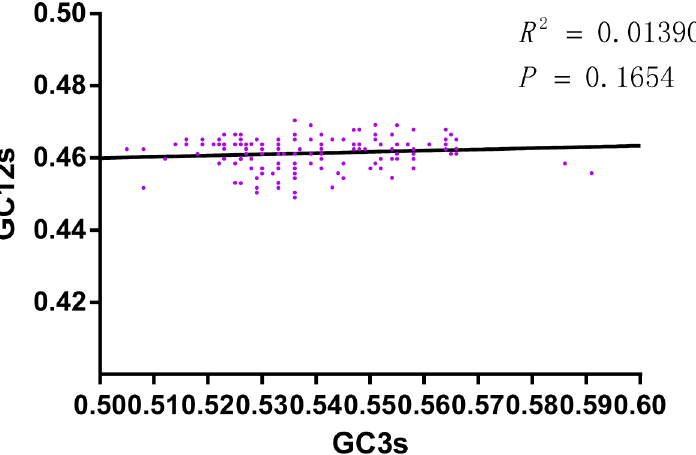
Fig 4. Neutrality analysis, with GC3s plotted against GC12s, displaying the key role between mutation pressureand natural selection.